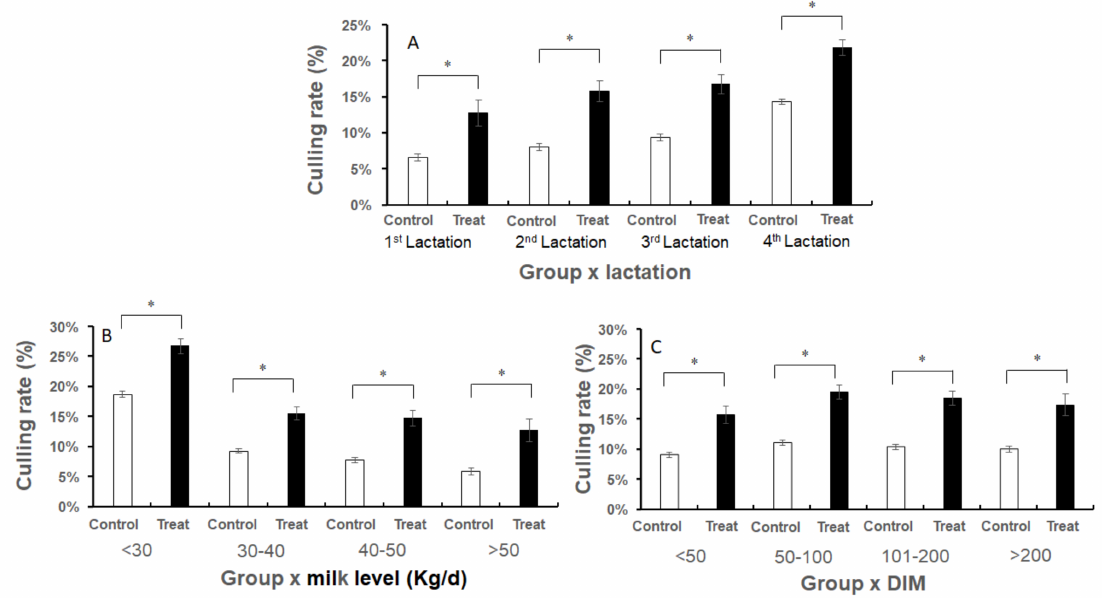
Figure 1. Culling rates of treated (Treat) vs. non-treated (Control) dairy cows due to mastitis according to different interactions. ( A ) Group x lactation number. ( B ) Group x milk level. ( C ) Group x DIM. Numbers of cows are presented in Table 4. Data are presented as mean ± SEM. * p <